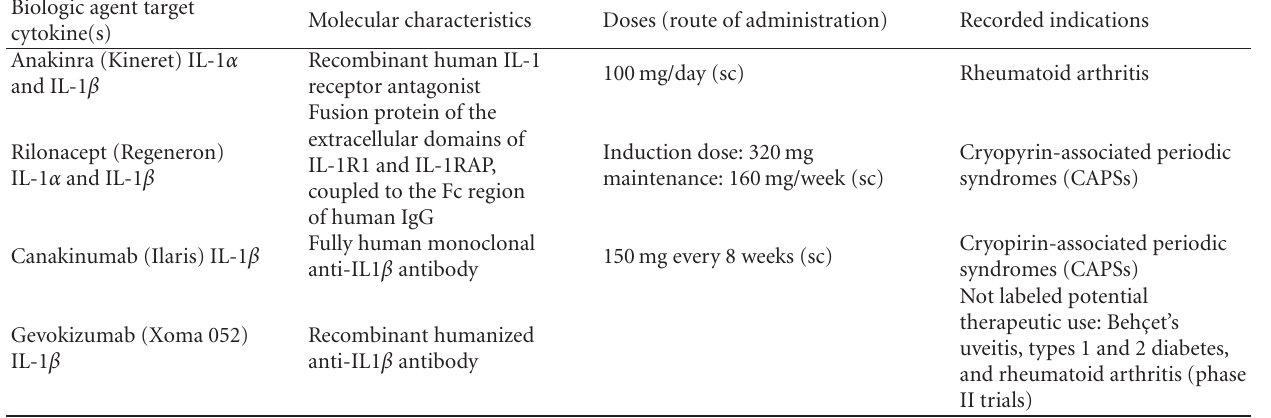
Table 1: Anti-IL1